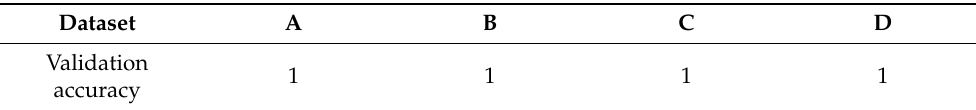
Table 3. The validation accuracy using different training